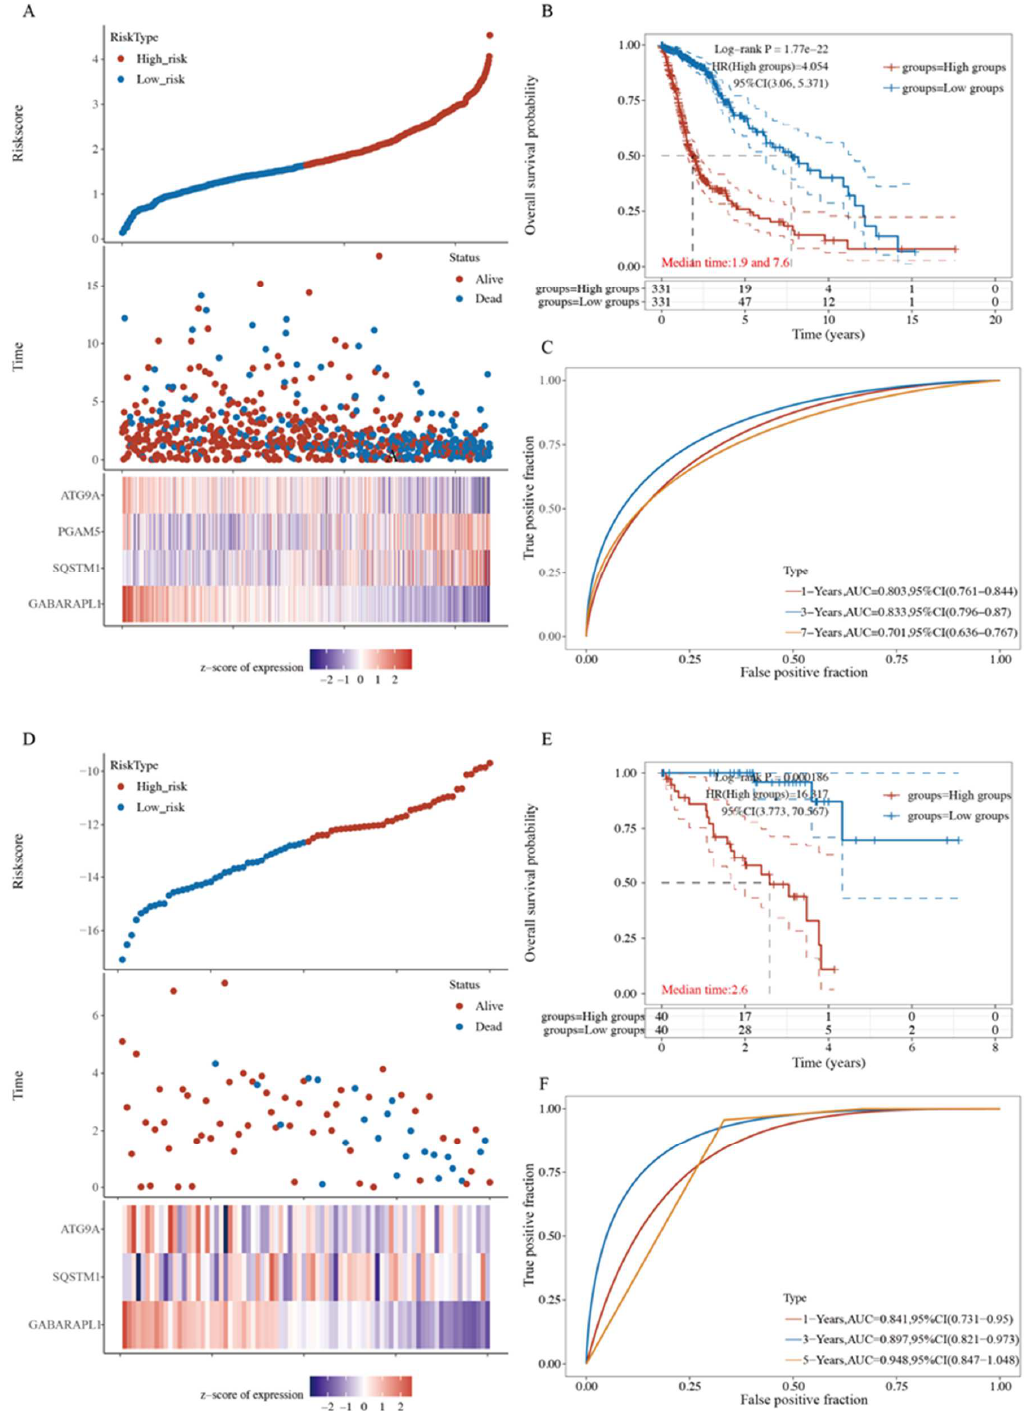
Figure 8. Four-gene signature validations in pan-cancer TCGA Cohort. ( A ) The risk score based on the mitophagy-related gene set in glioma patients. ( B ) The Kaplan–Meier curve of overall survival differences stratified by signature risk score in glioma patients. ( C ) The ROC curves of the signature for overall survival at 1, 3, and 7 years in glioma patients. ( D ) The risk score based on the mitophagy-related gene set in uveal melanoma patients. ( E ) The Kaplan–Meier curve of overall survival differences stratified by signature risk score in uveal melanoma patients. ( F ) The ROC curves of the signature for overall survival at 1, 3, and 5 years in uveal melanoma patients.